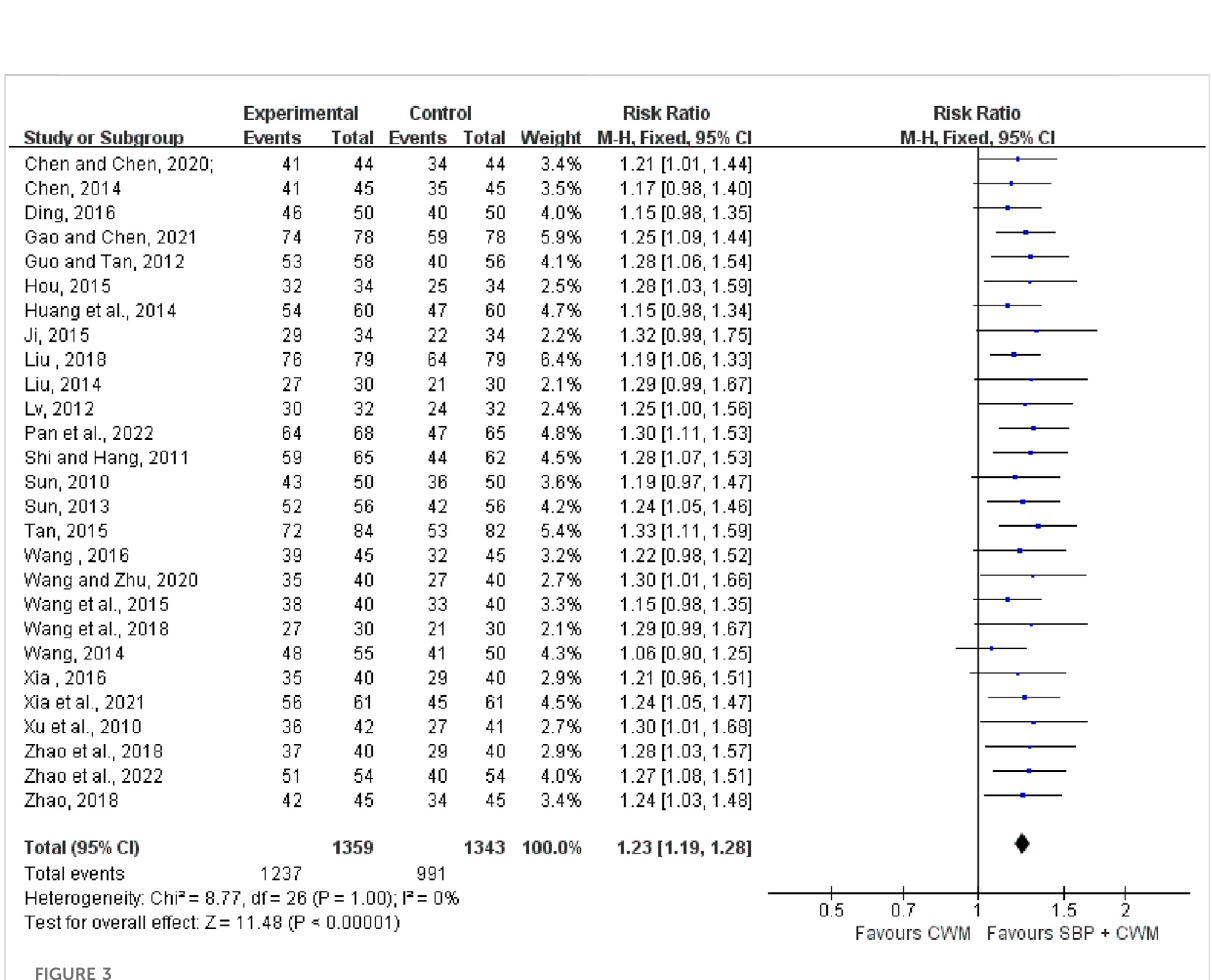
FIGURE 3 Forest plot of the total effective rate of angina symptom